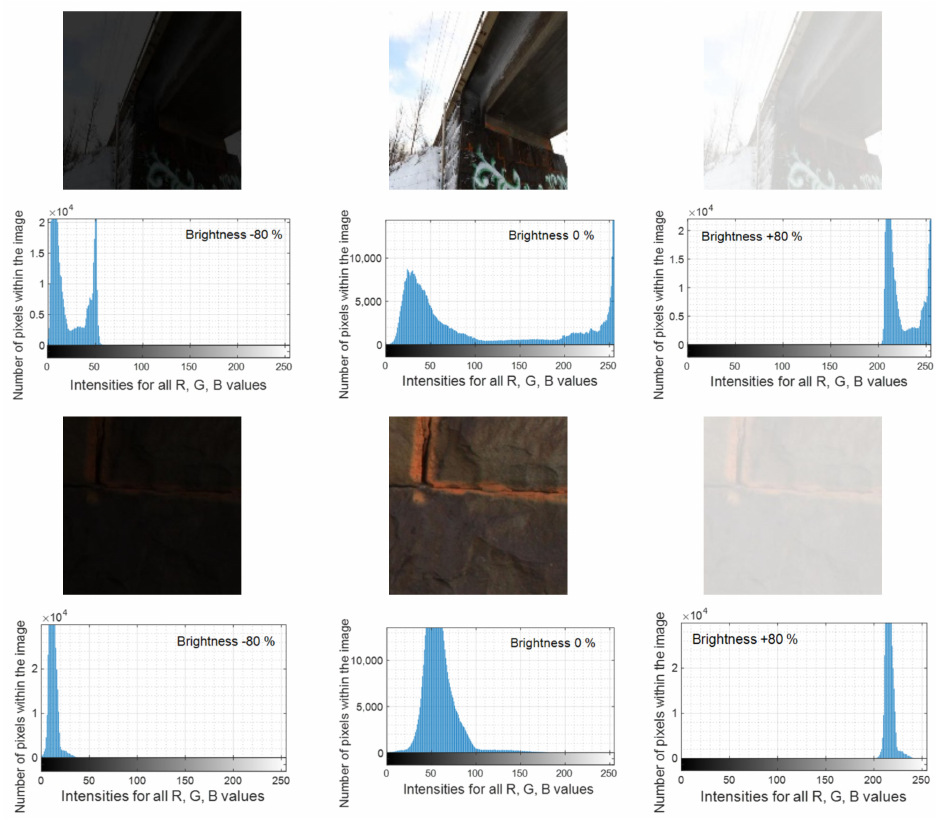
Figure 15. How the image histogram changes with changing brightness of the